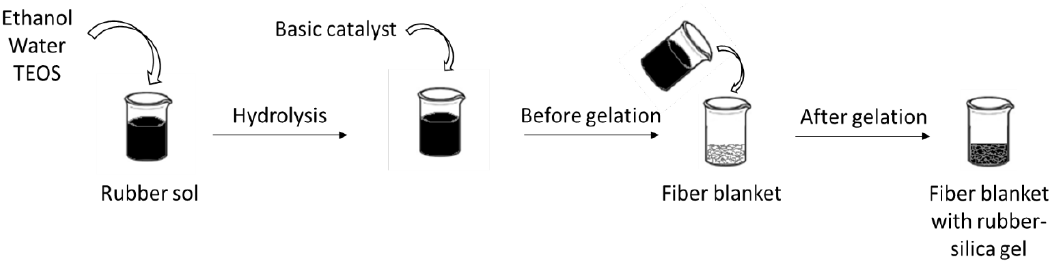
Figure 1. Illustration of the synthesis of the rubber-silica aerogel composite reinforced with